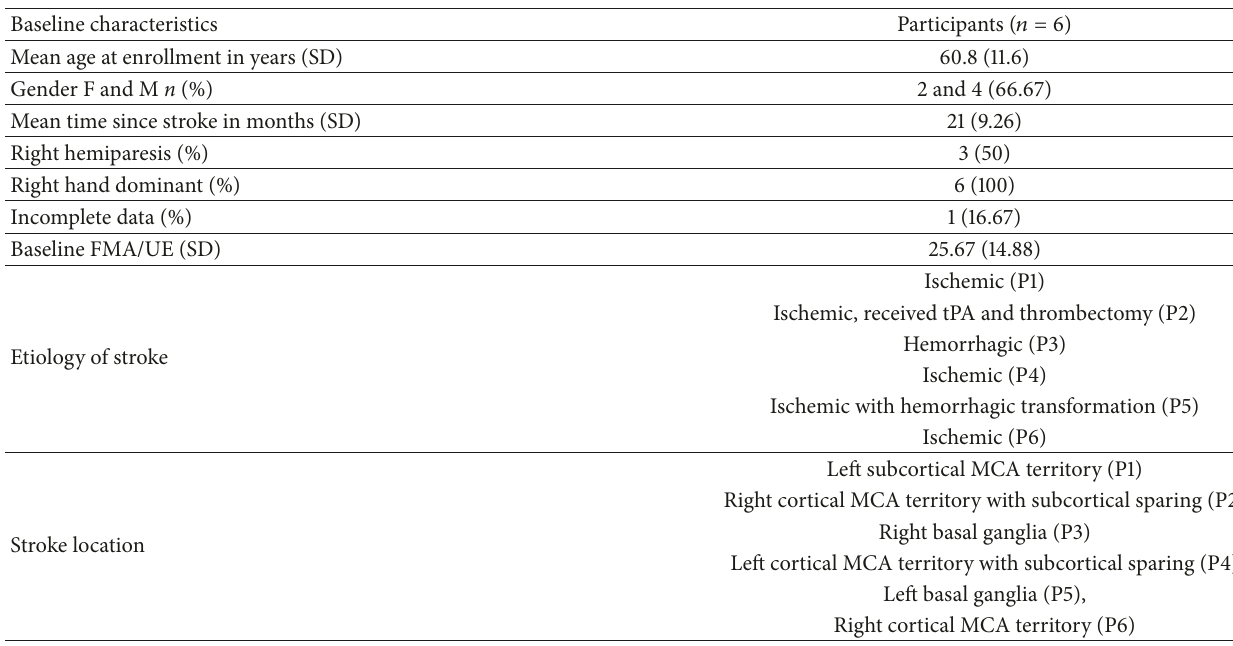
Table 1: Baseline characteristics of the